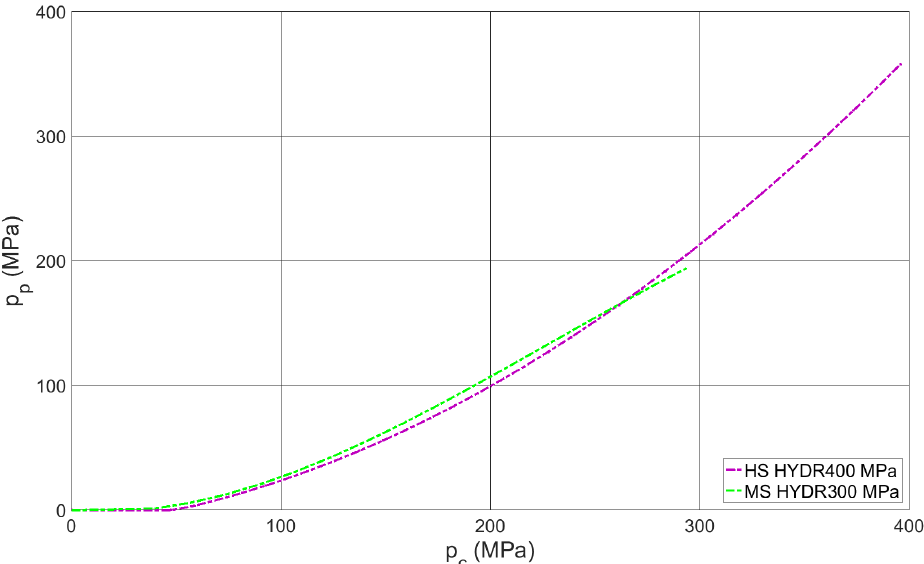
Figure 14. Validation of HS and MS sensors: interstitial pore pressure measurement vs. confinement pressure for R30A7 concrete samples under hydrostatic